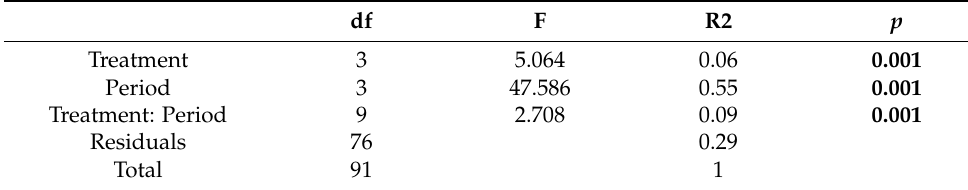
Table 2. Multivariate permutation analysis results.